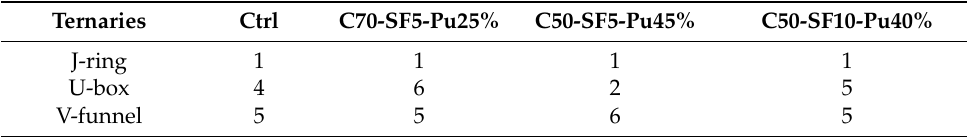
Table 5. Non-destructive tests value for each ternary